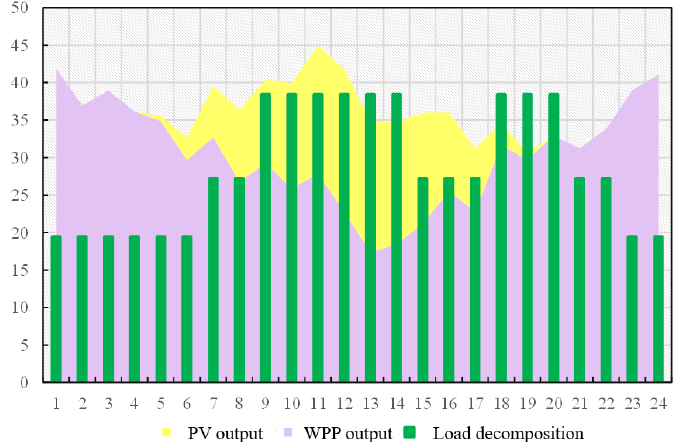
Figure 6. Average output of renewable energy in VPP (MWh).